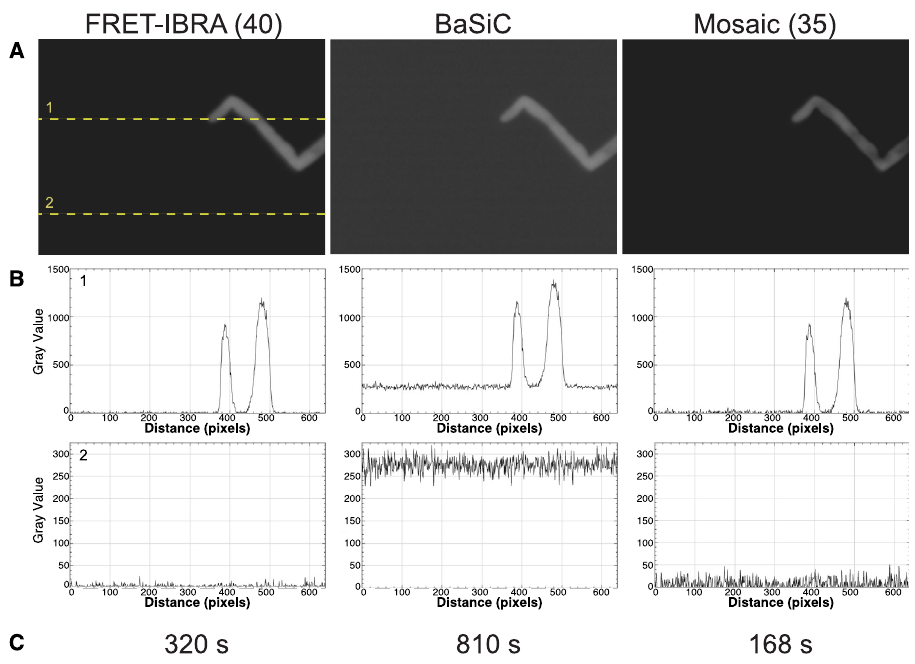
Fig 2. Comparison of FRET-IBRA with existing background subtraction plugins for ImageJ (BaSiC [10] and the background subtractor module of the Mosaic suite [12]). A) Frame 1 of the donor (CFP) channel after background subtraction. The dashed lines indicate the rows of pixels analysed in B). B) Pixel intensities after background subtraction. Top and bottom panels correspond to lines 1 and 2, respectively. C) Runtime for the background subtraction for 1000 frames. All tests were run on 4 cores with an Intel Core i7 (Quad-Core, 2.8GHz, 16GB RAM) computer.